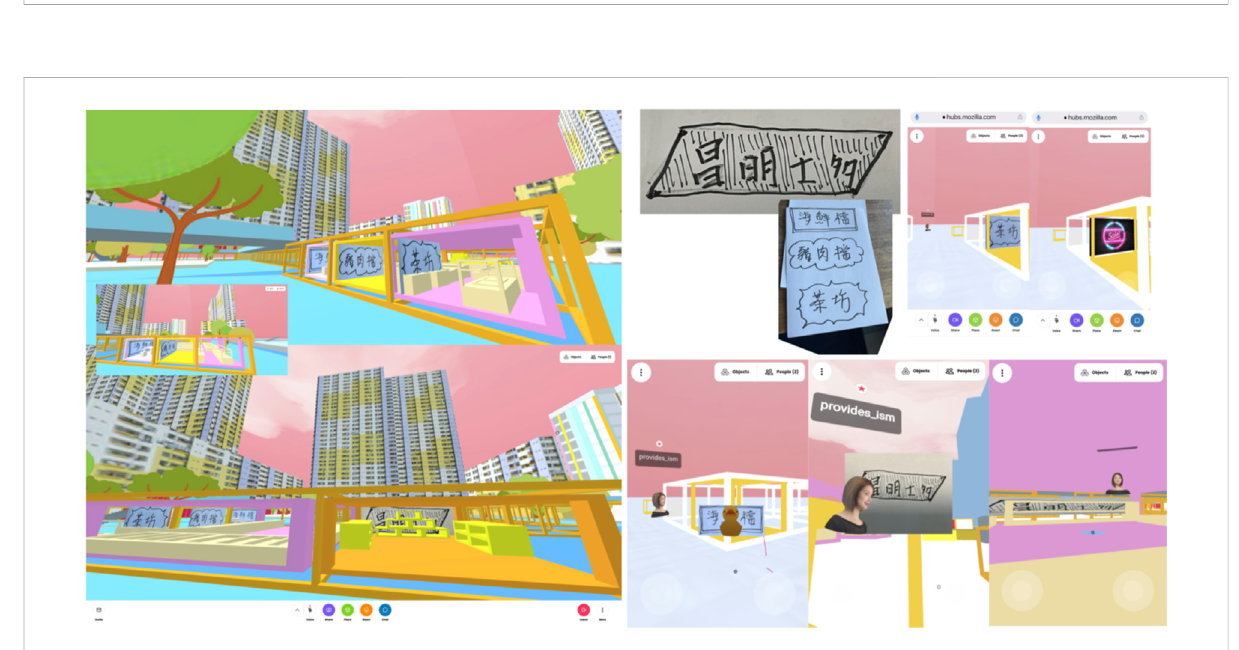
FIGURE 8 Integrating physical hand drawings into the VR game to facilitate customisation and intuitive expression by